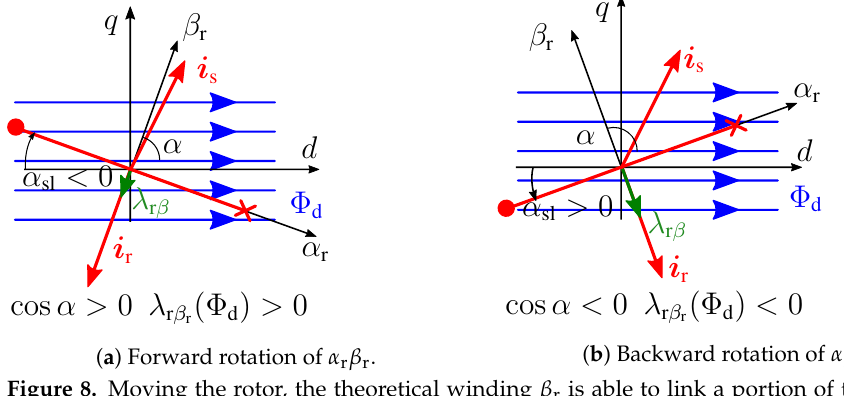
Figure 8. Moving the rotor, the theoretical winding β r is able to link a portion of the d -axis flux, according to sin α